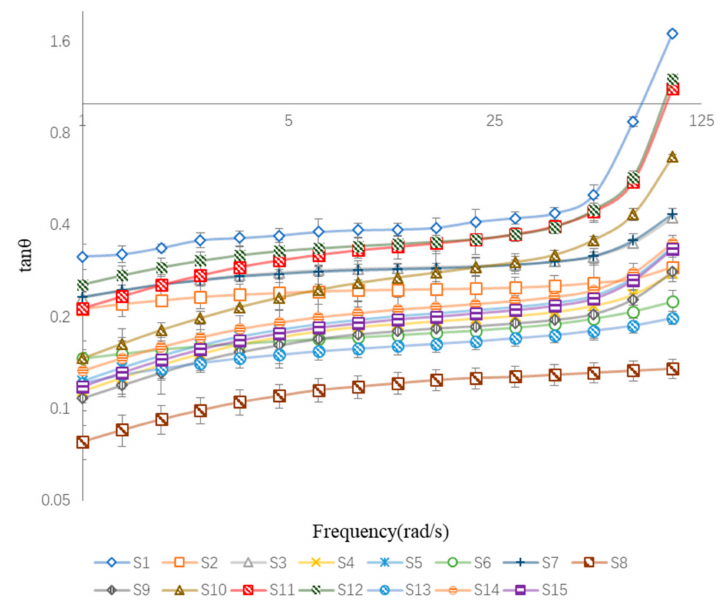
Figure 5. The tan θ as a function of frequency for samples of felbinac